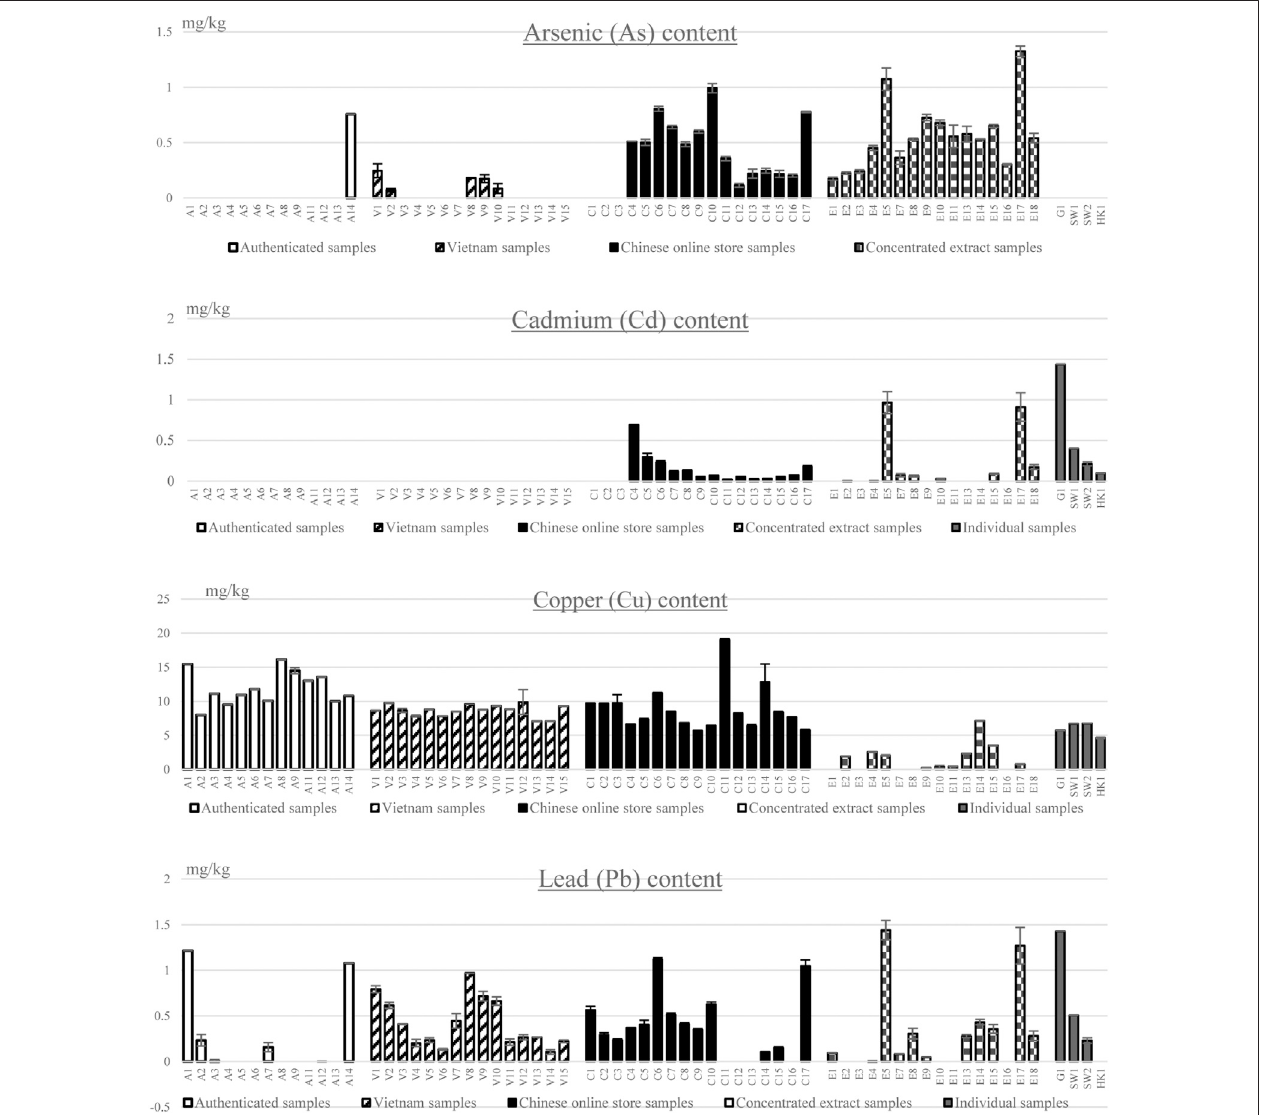
FIGURE 1 | Heavy metal analysis of authenticated samples (A1 – A14), Vietnamese samples (V1 – V15), Chinese online stores samples (C1 – C17) and concentrated extracts (E1 – E5, E7 – E11, and E13 – E18) as well as some individual samples (G1, SW1, SW2, and